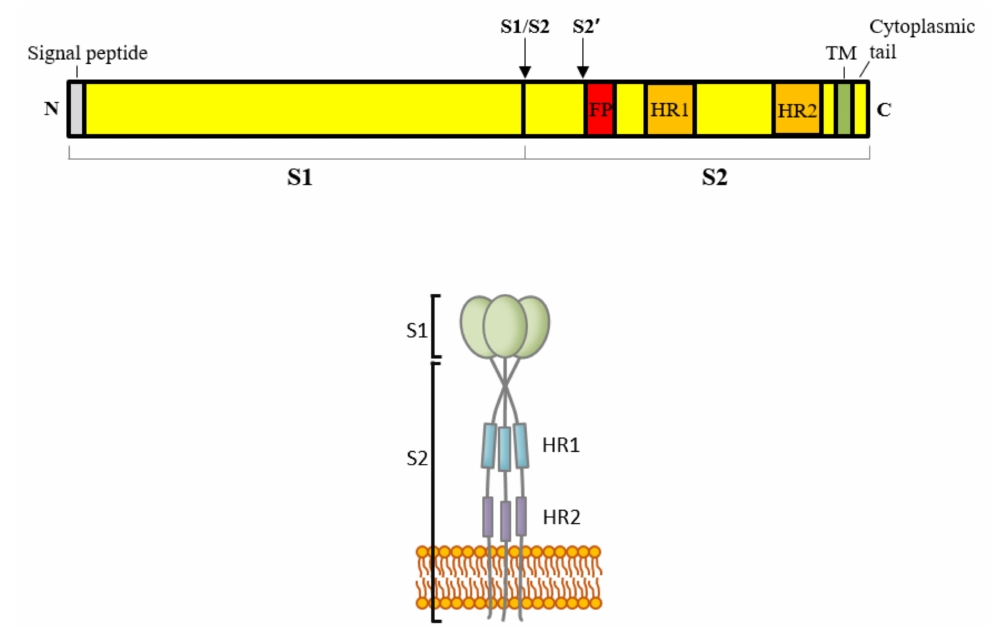
Figure 2. Schematic diagram of the domain architecture of coronaviral spike (S) proteins. Upper panel: domain architecture. Lower panel: a model of S trimer where the S1 forms a globular head and the S2 forms a narrow stalk. FP: fusion peptide. HR1: heptad repeat 1. HR2: heptad repeat 2. TM: transmembrane domain. S1/S2 and S2 (cid:48) are two types of proteolytic cleavage sites. The S1 domain is required for receptor binding, while the S2 domain mediates membrane